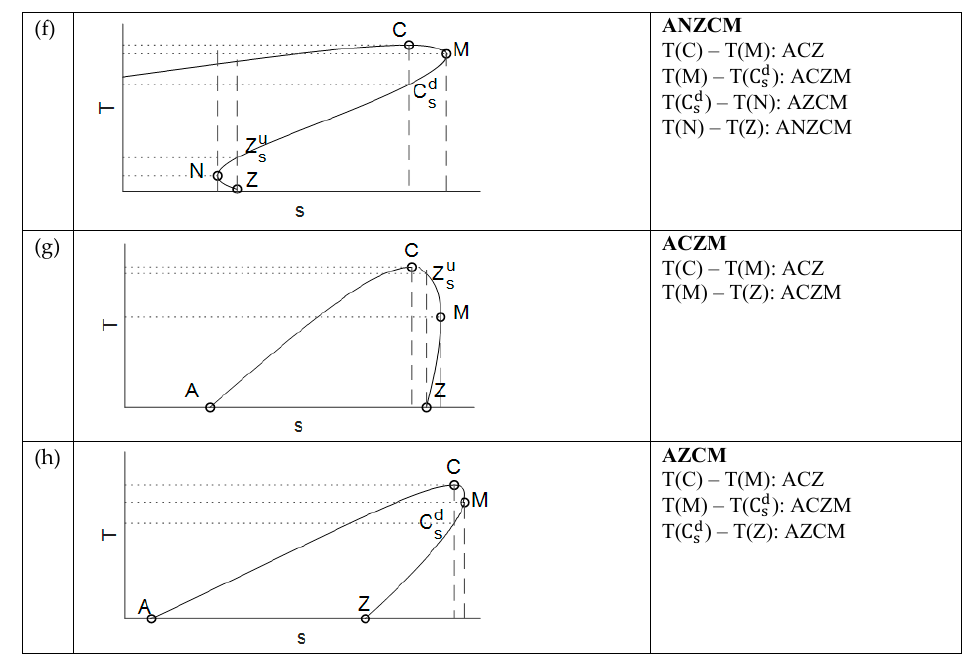
Figure A1. Temperature-dependent classification scheme for various working fluid classes.